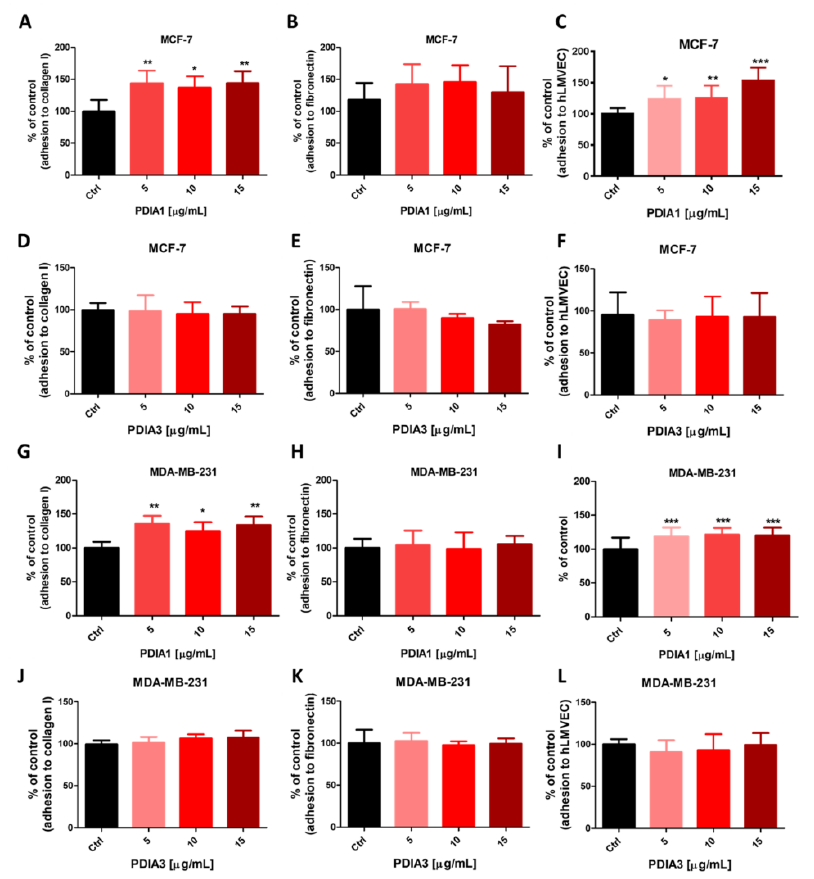
Figure 4 . Effects of exogenous PDIA1 and PDIA3 on adhesive interaction between breast cancer cells and different substrates. Effect of exogenous proteins PDIA1 and PDIA3 on adhesion of MCF-7 ( A – F ) and MDA-MB-231 ( G – L ) cells to collagen type I, fibronectin and lung microvascular hLMVEC cells, respectively. Data represent mean ± SD of three independent experiments. Statistical analysis was performed using one-way ANOVA followed by Dunnett’s multiple comparisons test (* p = 0.05, ** p = 0.01, *** p = 0.001).